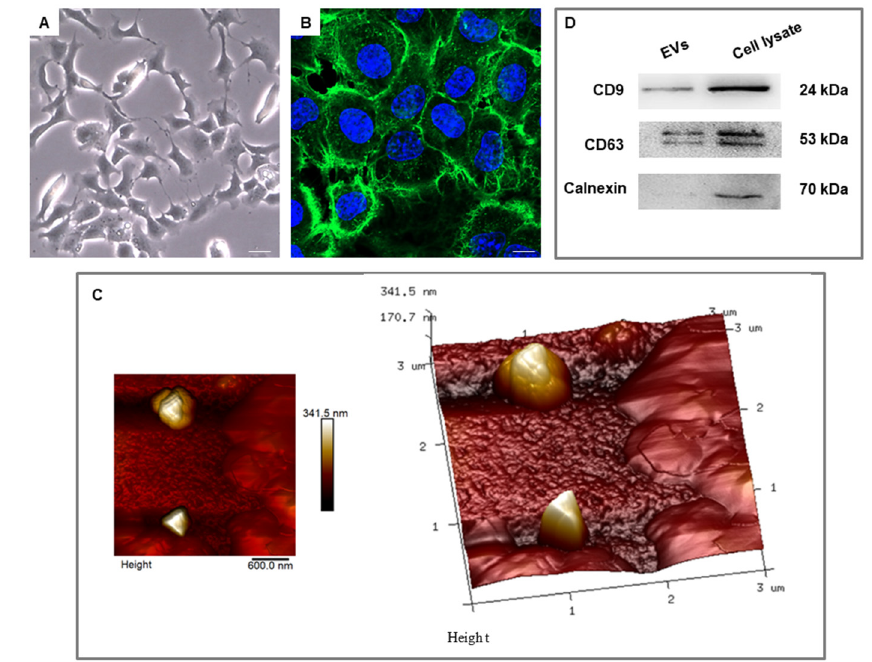
Figure 2. HL-1 cell culture and derived extracellular vesicles (EVs). ( A ) HL-1 morphology observed under inverted light microscopy (10×). Scale bar: 0.2 μ m. ( B ) Immunofluorescence staining of HL-1 observed under confocal microscopy (63×). The nuclei were highlighted in blue, while the actin of the cytoskeleton was highlighted in green. Scale bar: 10 μ m. ( C ) EVs were analyzed under atomic force microscopy to evaluate their morphological aspect. ( D ) Western Blot experiments of CD9, CD63, and Calnexin performed on cell lysate used as controls and on a fraction of the EVs.